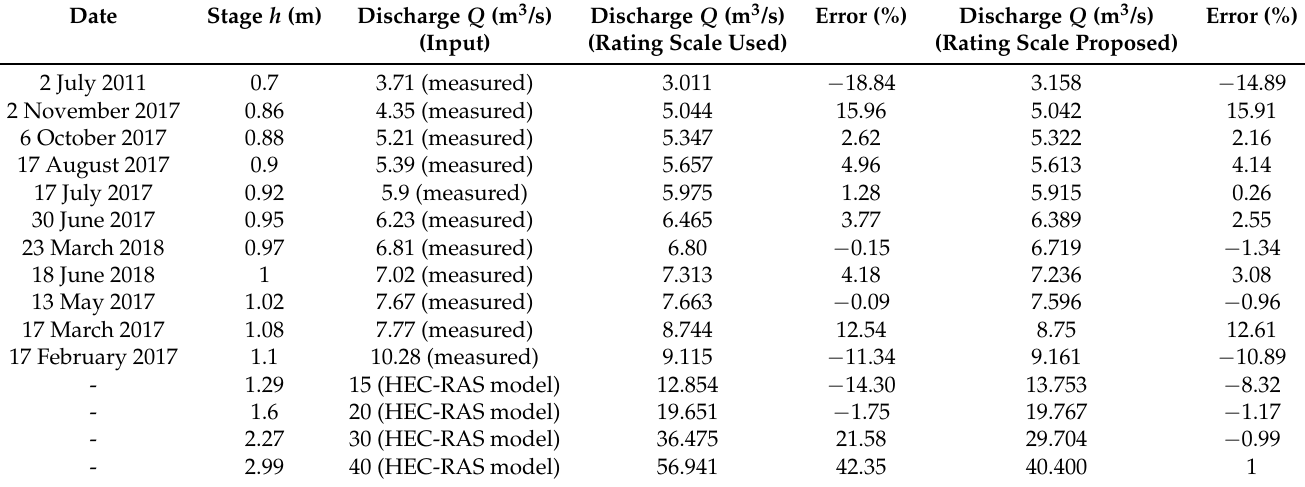
Figure 15. Information about the station located along the Nera River, municipality of Visso (MC). ( a ) Marche Region, where the red dot indicates the investigated area of the Nera River, in the municipality of Visso. ( b ) Hydrometric rod position on the Nera River located in Visso. Table 4. Visso station on the Nera River. HEC-RAS model: steady flow analysis, mixed flow regime, boundary conditions (upstream condition: critical depth setting, downstream condition: critical depth setting), and Manning’s roughness coefficient (riverbed = 0.03, floodplains =